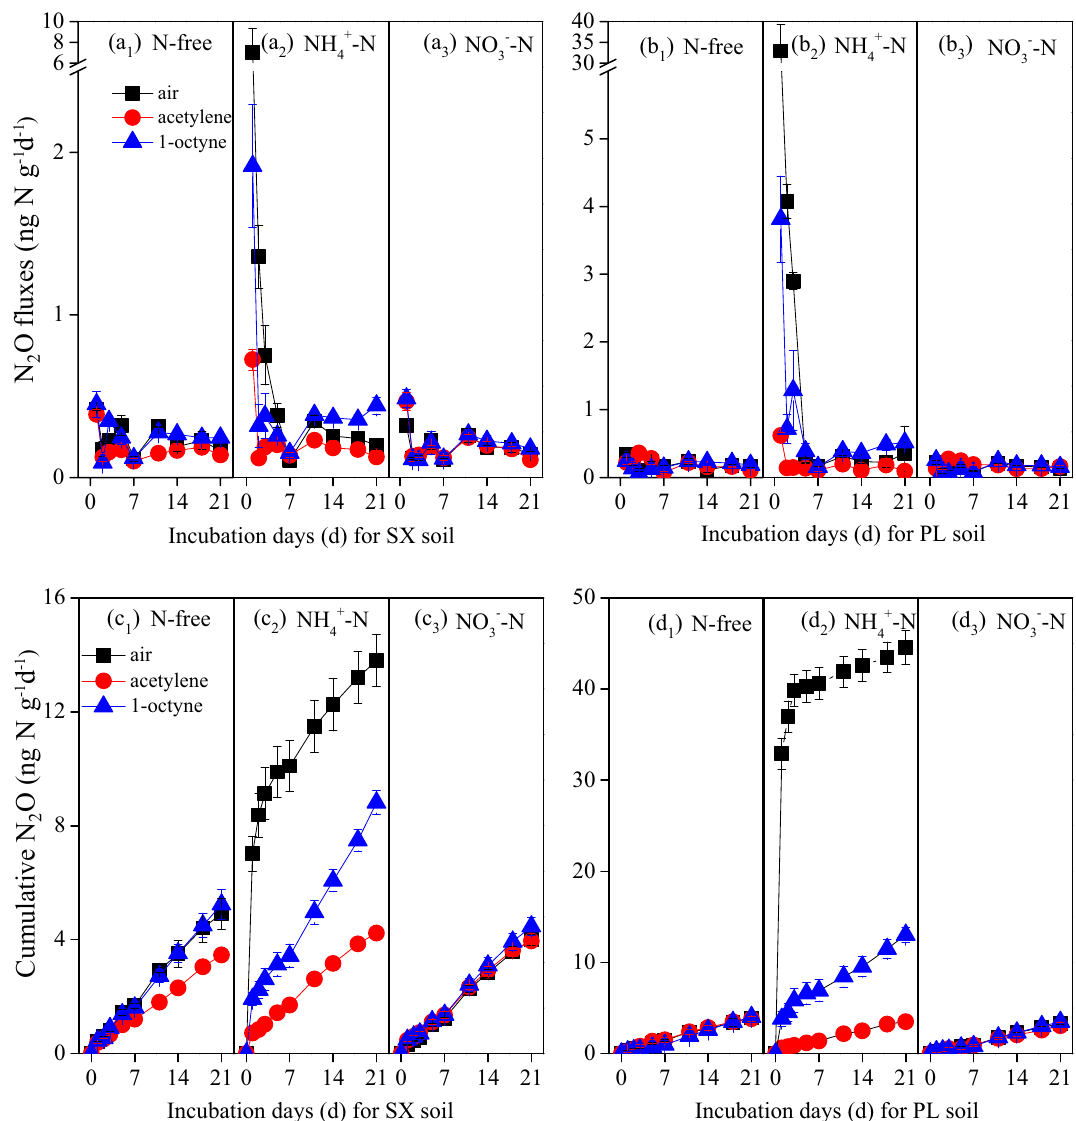
Figure 2. The N 2 O emission fluxes and accumulated fluxes with different N fertilizers (N-free, ammonium-N, nitrate–N) in combination with air (no inhibitors), acetylene and 1-octyne after 21 days incubation in SX ( a and c ) and PL ( b and d ) soil, error bars represent standard errors of three biological